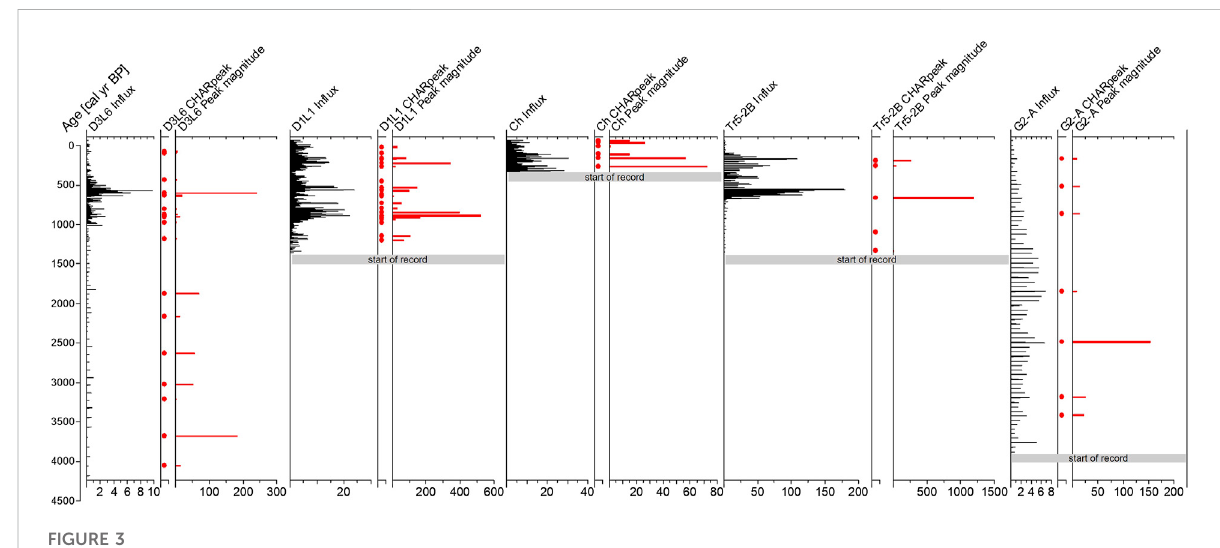
FIGURE 3 Altai Tavan Bogd NP macro-charcoal in fl uxes (particles/cm 2 yr), peaks, and respective peak magnitudes (particles/cm 2 peak) based on